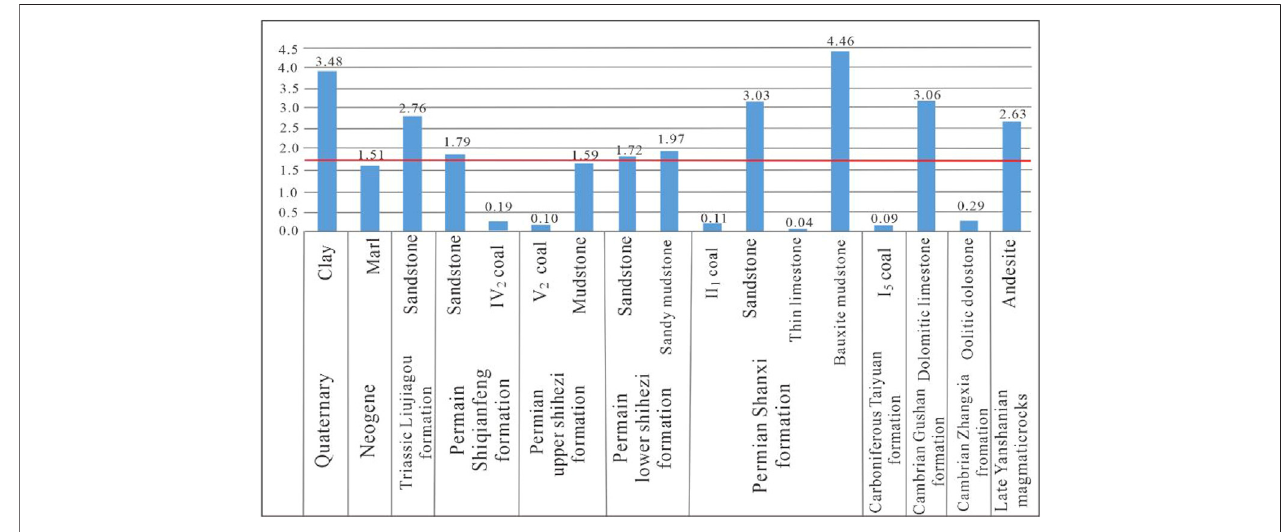
FIGURE 6 | Potassium-40 content in the different strata (%).